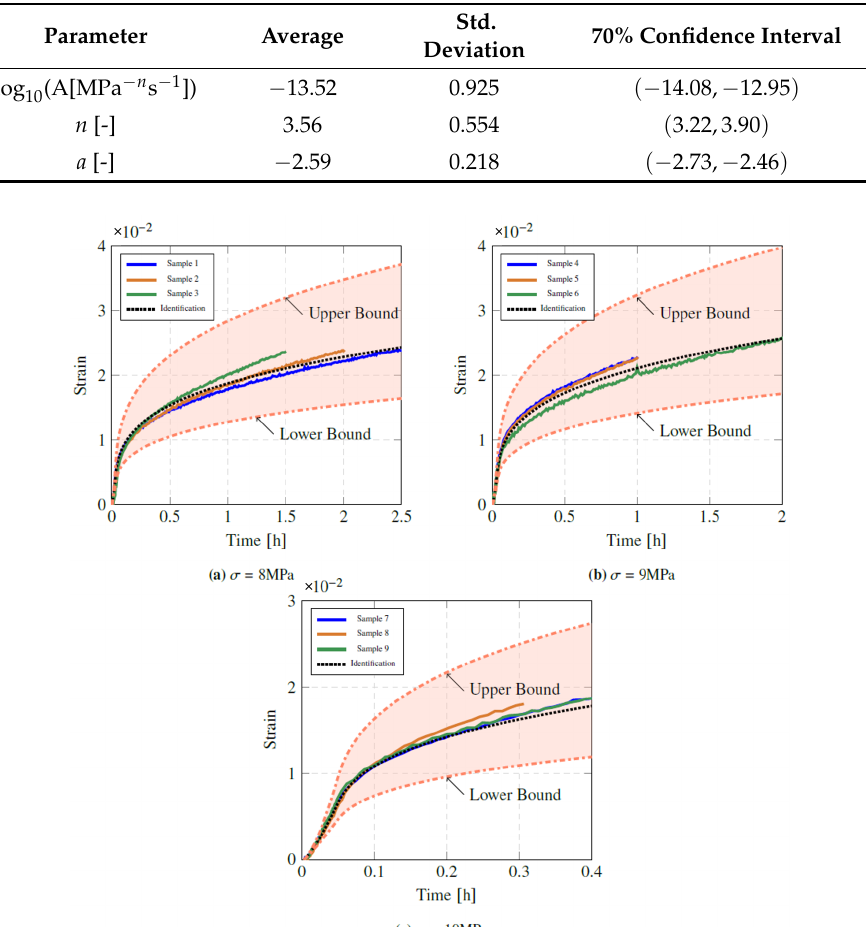
Figure 6. Compressive creep identification results at T = 1300 ◦